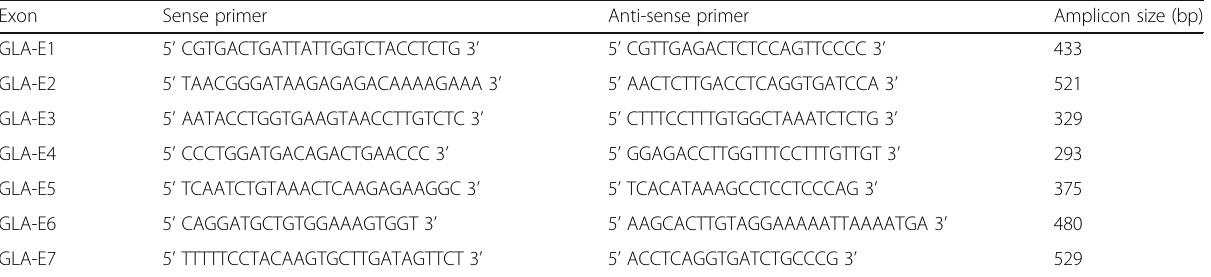
Table 1 Primer sequences and amplicon sizes for GLA gene